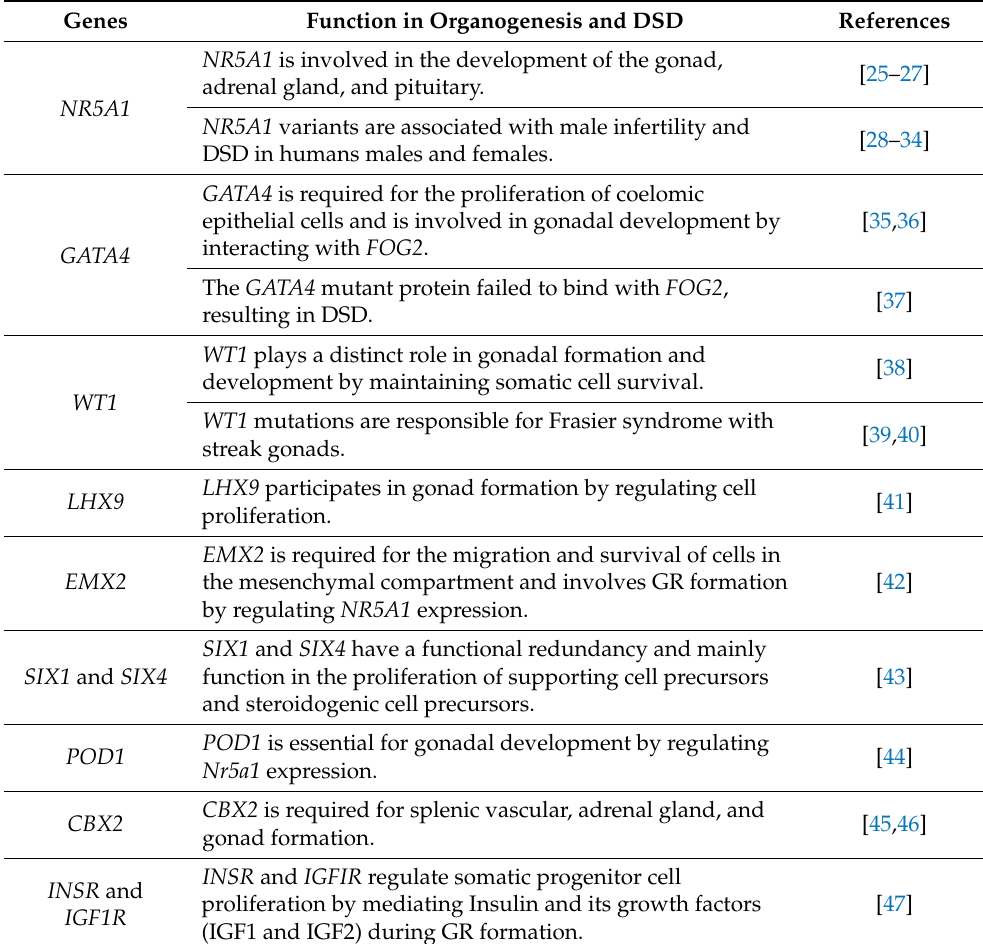
Table 1. Genes involved in genital ridge